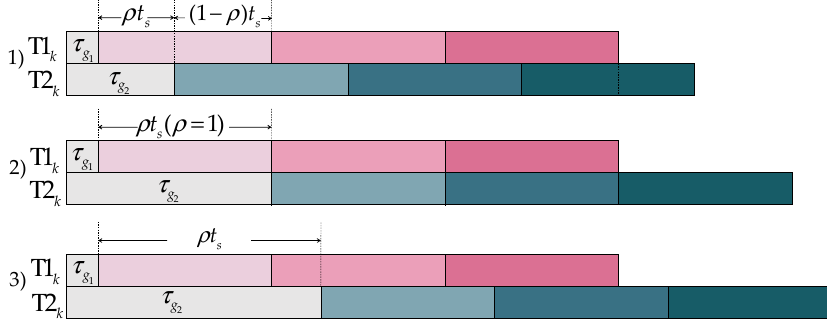
ρ . Figure 5. Different transmission situations with different values of ρ